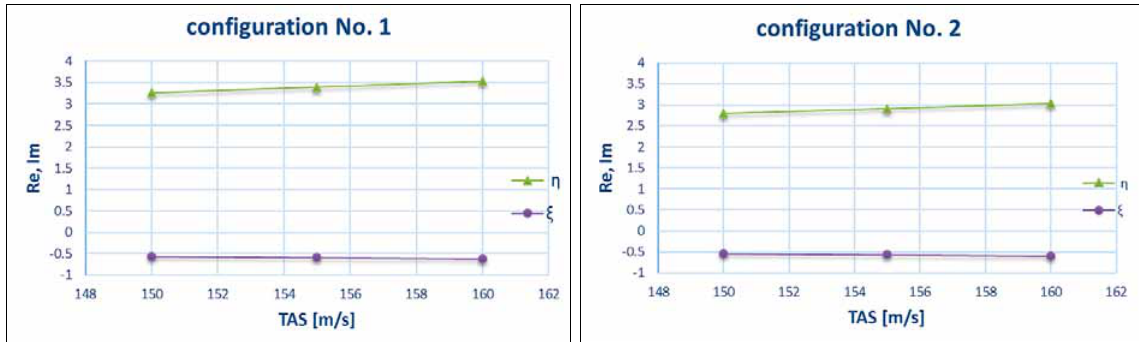
Fig. 11. Eigenvalues of the real and imaginary part for the short period